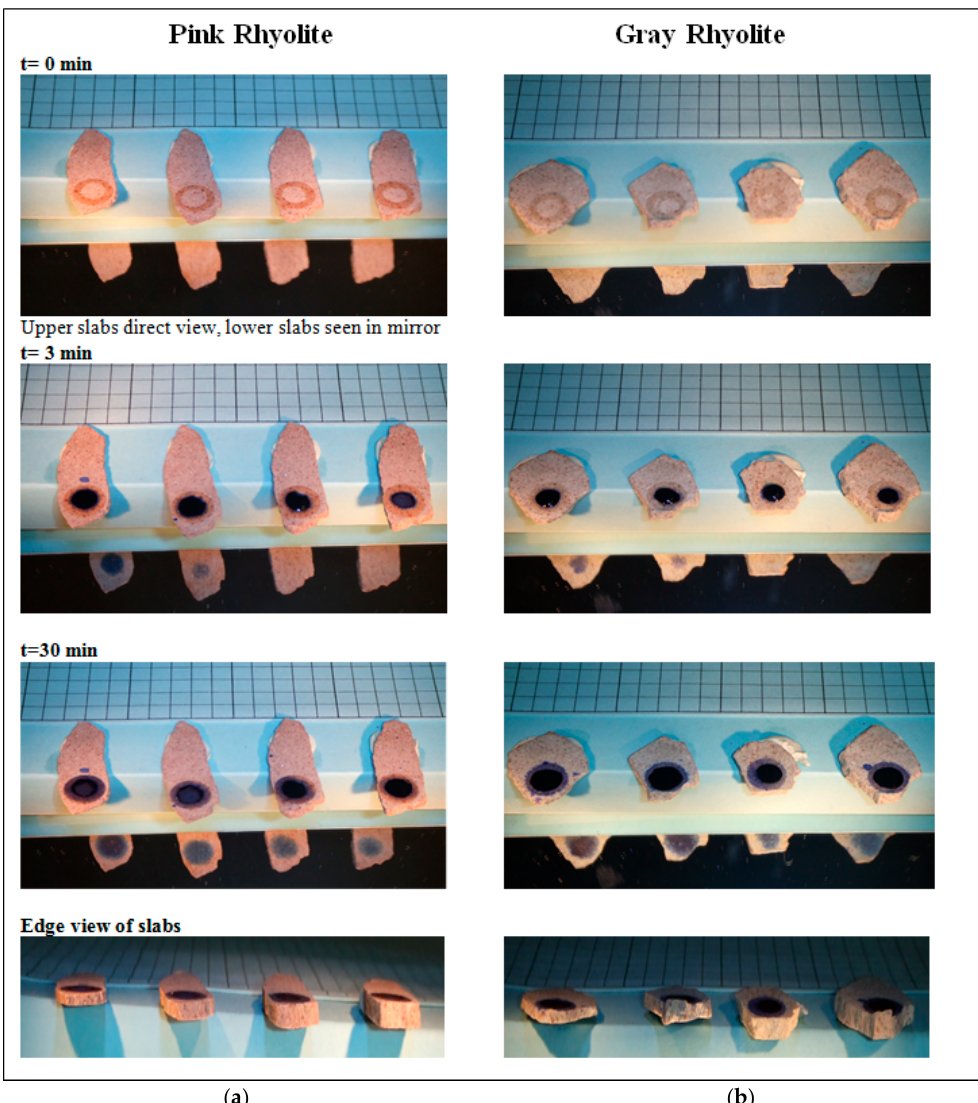
Figure 7. Timed ink penetration of rhyolite slabs to determine permeability. Boxes = 0.5 cm. ( a ) Pink rhyolite; ( b ) Gray rhyolite. Circles seen at t = 0 are the ridges created by nail polish, which serve to contain and restrain the ink.